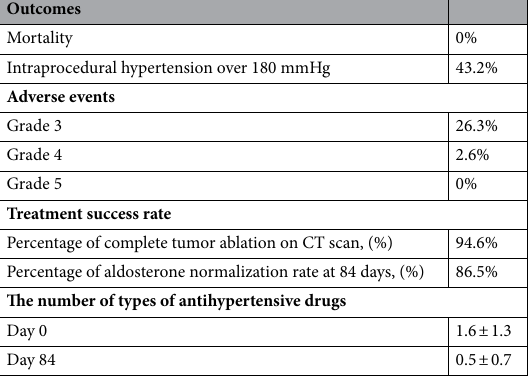
Table 2. Outcomes of CT-guided percutaneous radiofrequency ablation. CT Computed